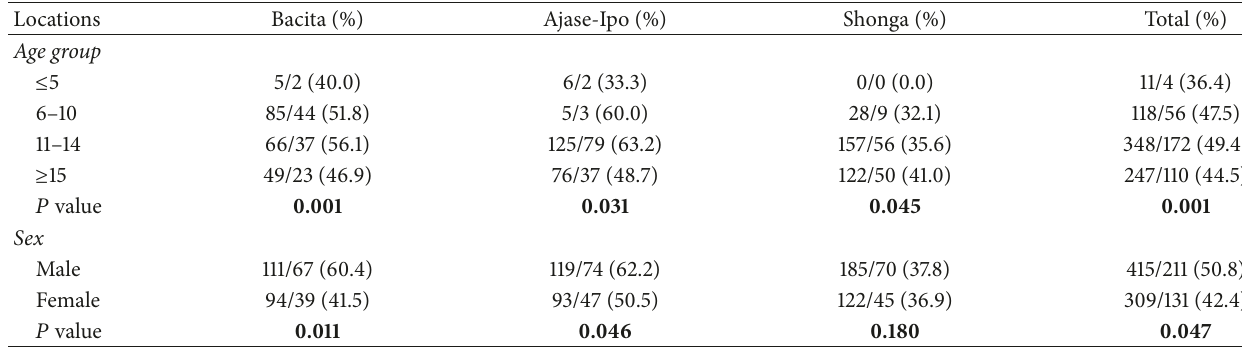
Table 2: Infection pattern with respect to the age and sex of the study participants. Locations